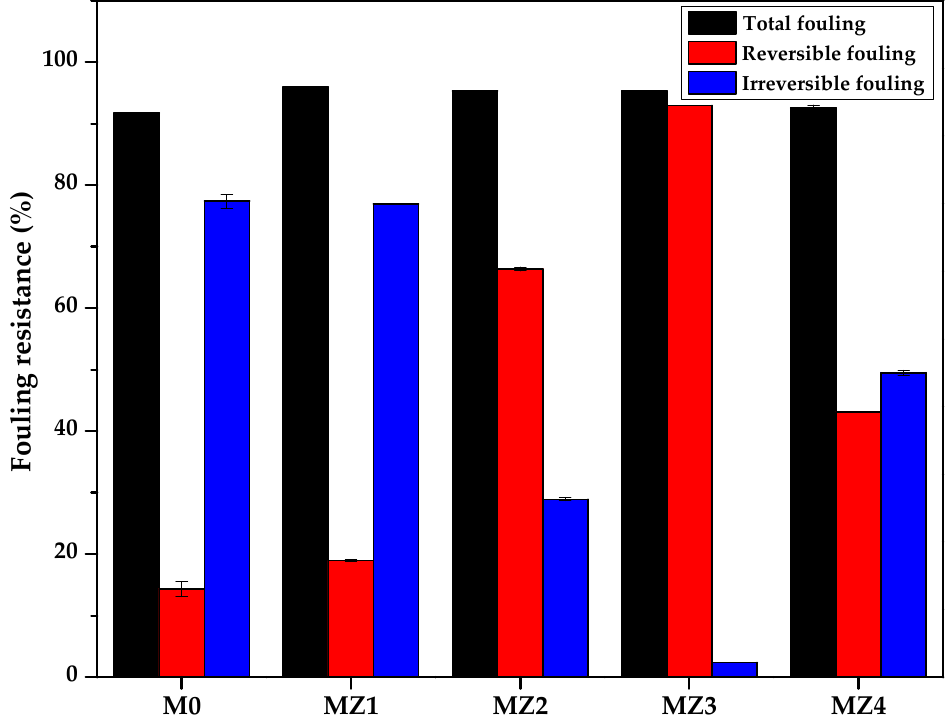
Figure 12. Fouling parameters of the fabricated membranes.